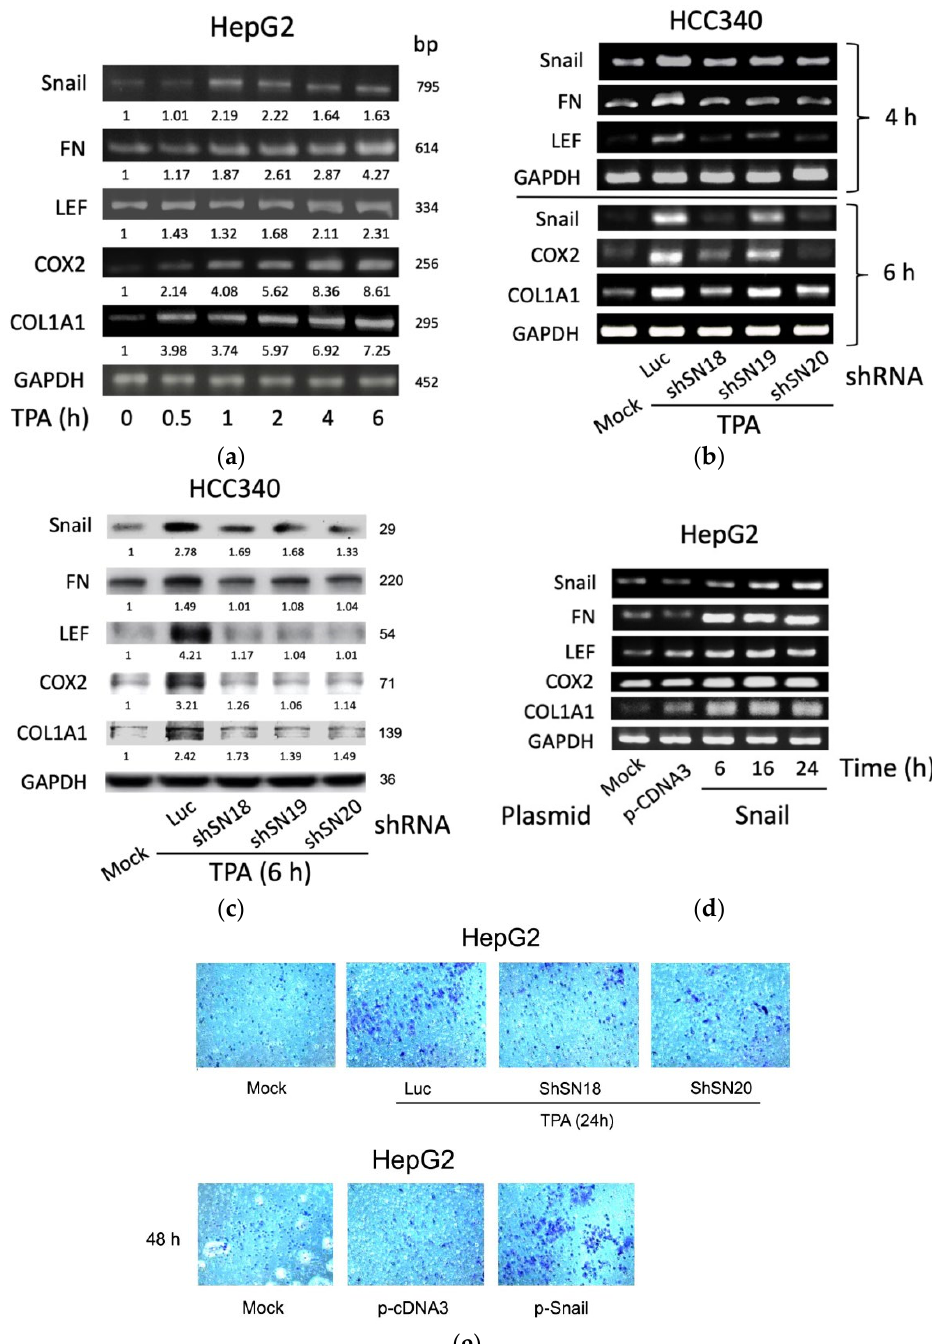
Figure 1. SNA is essential for constitutive and required TPA-induced gene expression of FN, LEF, COX2, and COL1A1 and cell migration of HCCs. HepG2 cells were treated with 50 nM TPA for the indicated time ( a ), HCC340 cells were transfected with luciferase shRNA (Luc) or different shRNAs of SNA for 24 h followed treated with TPA for 4 h (( b ), upper panel), 6 h (( b ), lower panel and ( c )) and 24 h (( e ), upper panel), HepG2 were transfected with SNA expressing plasmid for the indicated time ( d ) (( e ), lower panel), using p-CDNA3 as a control vector. RT/PCRs ( a , b , d ), Western blot ( c ) of the indicated genes and transwell migration assay ( e ) were performed. In ( a – d ), GAPDH is used as an internal control. The data shown are representative of three reproducible results. In ( a , c ), the numbers indicated below each band are averaged relative intensities (Coefficient of Variation: 7–10%), taking time zero ( a ) or MOCK group ( c ) as 1.0.